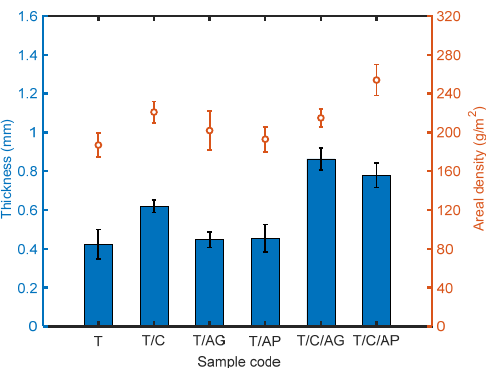
Figure 6. Thickness and areal density of the electro-sprayed materials.